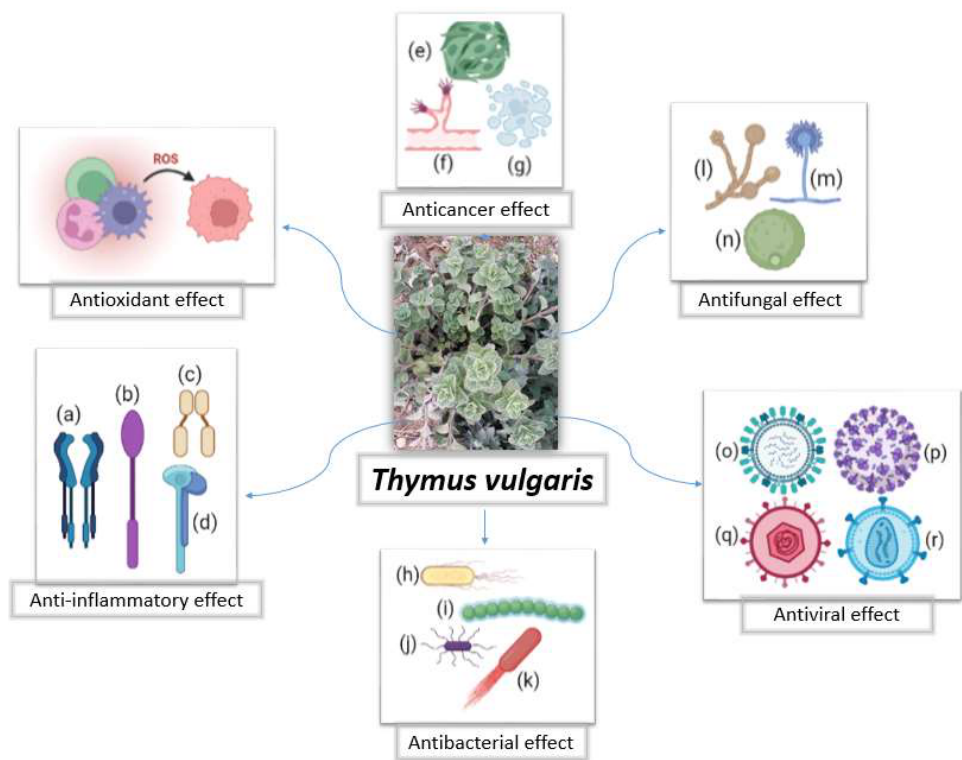
Figure 3. A photo of Thymus vulgaris with a summary of some of its biological effects. ROS: reactive oxygen species; ( a ) interferon; ( b ) tumor necrosis factor (TNF)-α; ( c ) nuclear factor-kappa B (NF-кB); ( d ) interleukin; ( e ) proliferation; ( f ) angiogenesis; ( g ) apoptosis; ( h ) Escherichia coli ; ( i ) Streptococcus ; ( j ) Bacillus ; ( k ) Listeria ; ( l ) Candida ; ( m ) Aspergillus ; ( n ) Cryptococcus ; ( o ) influenza virus; ( p ) severe acute respiratory syndrome coronavirus-2 (SARS-CoV-2); ( q ) herpes virus; ( r ) human immunodeficiency virus (HIV). Thyme photo is courtesy of the authors and the figure was prepared using BioRender.com, accessed on 31 March 2022.